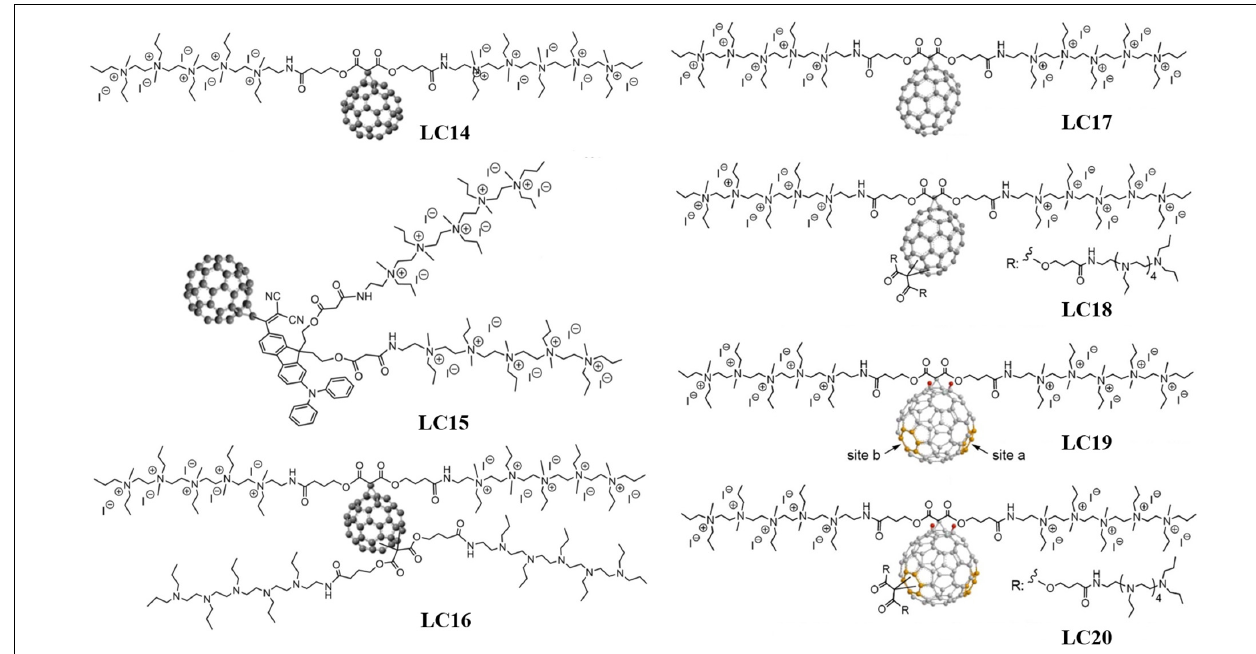
FIGURE 4 | Molecular structures of the fullerene-cyclopropane derivatives, LC14–LC20 (Sperandio et al., 2013; Yin et al., 2015).